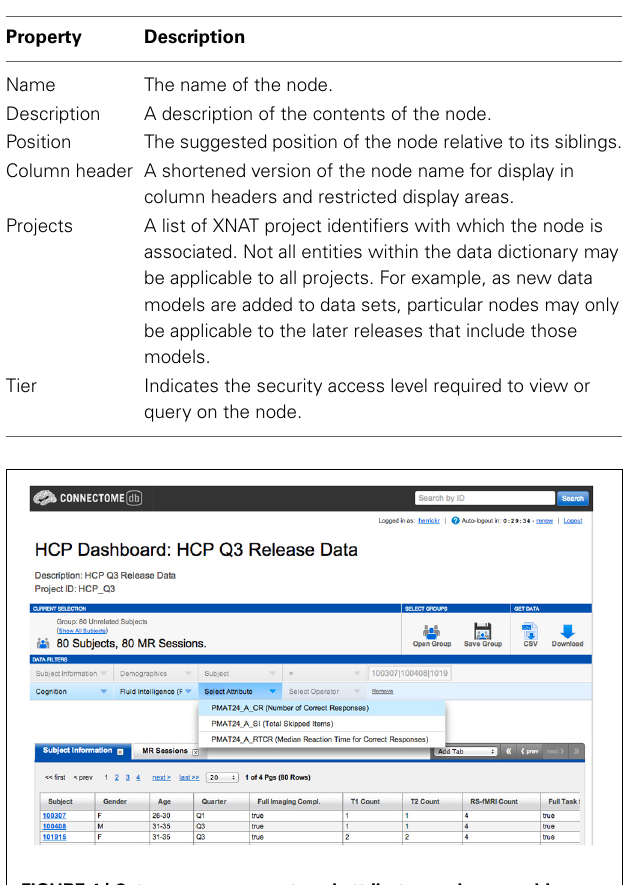
Table 2 | Defining category node-type properties in data-dictionary.